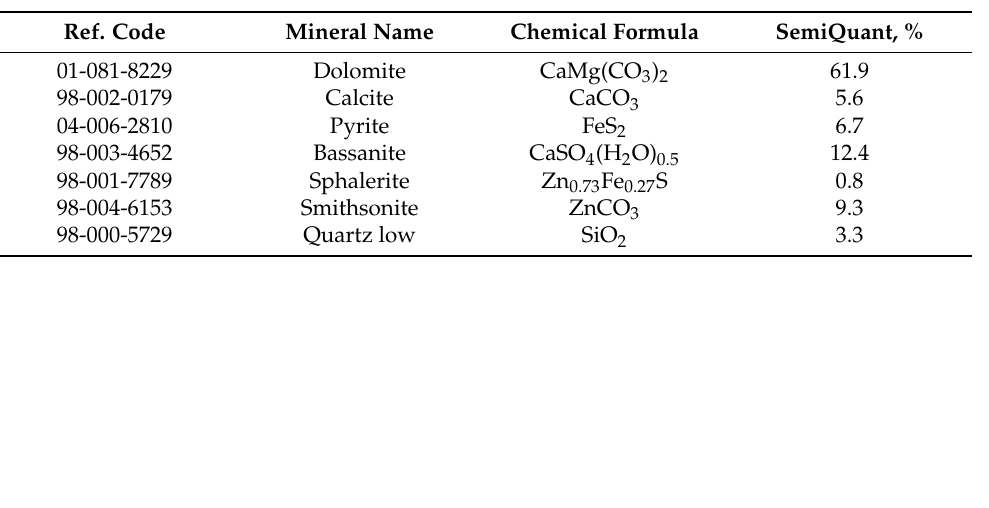
Table 2. The main mineral phases in dolomite